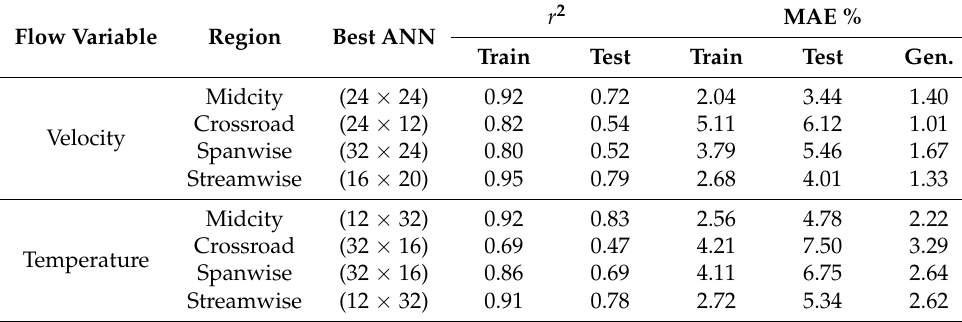
Table 9. Velocity discrete points’ prediction with ANN.